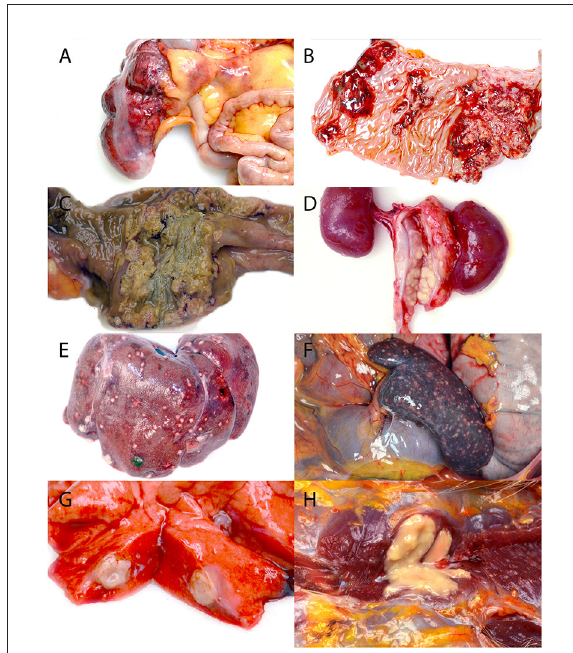
FIGURE1 Gross lesions associated with the systemic yersiniosis epizootic, vervets, multiple organs. (A) Typhlitis, cecum, case 17. Bright red hemorrhages diffusely cover the serosal surface of the colon, and the wall is markedly thickened. (B) Gastritis, stomach, case 15. The mucosa is ulcerated and hemorrhagic in several coalescing regions. (C) Colitis, colon, case 17. A yellow to green-gray fibrinonecrotic pseudomembrane covers the ulcerated colonic mucosa. (D) Lymphadenitis, renal lymph node, case 10. Markedly enlarged renal lymph nodes are replaced by yellow caseous material. (E) Hepatitis, liver, case 18. Off-white nodules up to 3mm in diameter are present on the surface of the liver. (F) Splenitis, spleen, case 13. The spleen is enlarged, and myriad, tan to red, 0.5–1mm diameter foci are scattered across the surface. (G) Pneumonia, lung, case 8. A 1cm diameter abscess effaces part of a middle lung lobe. (H) Myositis, right pectoralis muscle, case 16. A 1.5cm diameter abscess expands and replaces the